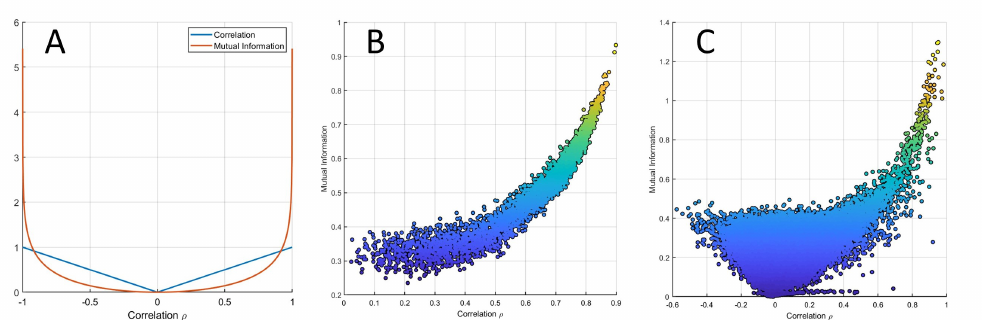
Figure 8. ( A ) MI MI ( X 1 , X 2 ) of two bivariate variables X 1 , X 2 linearly correlated with correlation ρ as a function of ρ . The two curves intersect at approximately ρ = 0.916. ( B ) MI versus Pearson’s correlation from data simulated with an average correlation of 0.6 (beta simulation). ( C ) MI versus Pearson’s correlation from experimental data (data set 3 from Table 1).